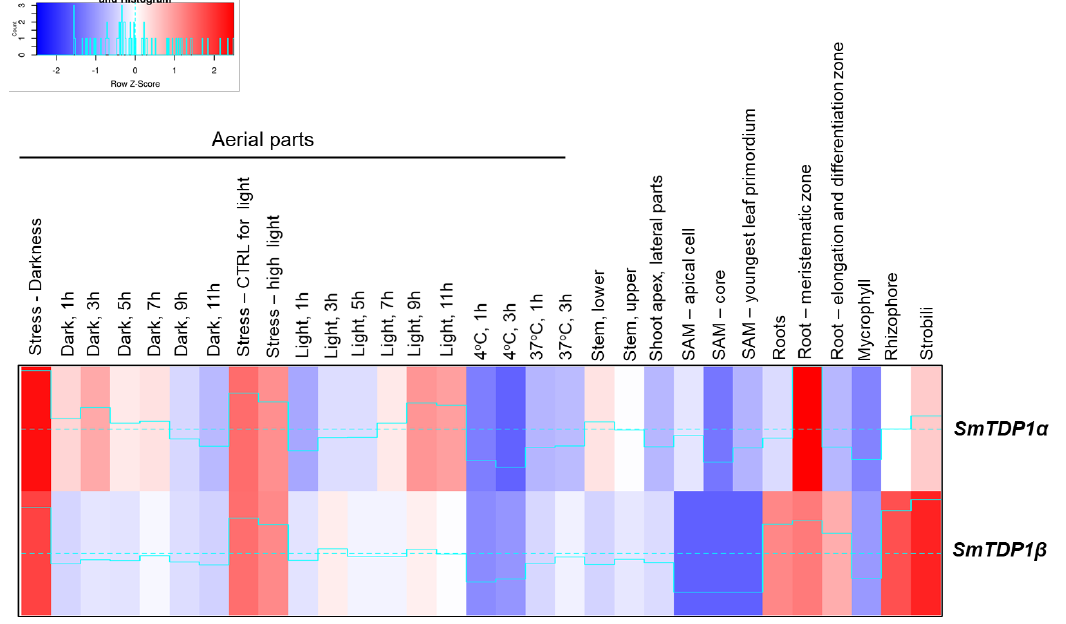
Figure 4. Expression profiles of the TDP1α (Smo170833) and TDP1β (Smo415650) genes in S. Figure4. Expressionprofilesofthe TDP1 α (Smo170833)and TDP1 β (Smo415650)genesin S.moellendor ffi i. moellendorffii. Data was collected from http://bar.utoronto.ca/efp_selaginella/cgi-bin/efpWeb.cgi and Data was collected from http: // bar.utoronto.ca / efp_selaginella / cgi-bin / efpWeb.cgi and heatmaps were heatmaps were generated using the Shinyheatmap (http://shinyheatmap.com/) application. generated using the Shinyheatmap (http: // shinyheatmap.com / )